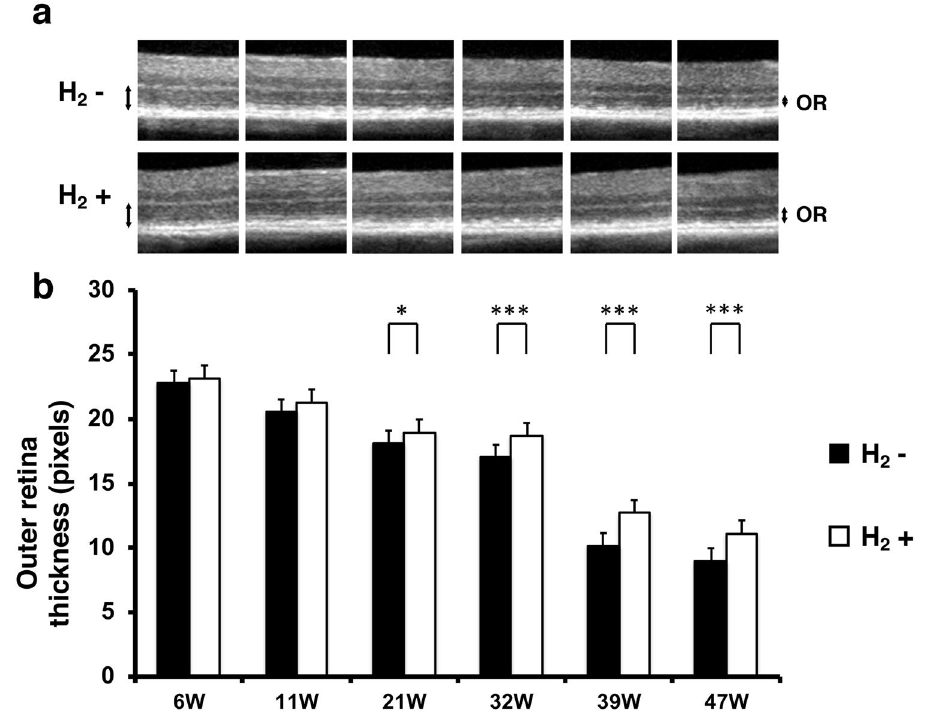
Figure 2. Effect of H 2 water on outer retinal thickness. ( a ) Representative retinal projections of OCT scans at 6–47 weeks of age. Double-headed arrows show the outer retina. OR outer retina. ( b ) Quantification of the outer retina thickness with/without H 2 water. The outer retina thickness with H 2 water (n = 10) was significantly greater than that without